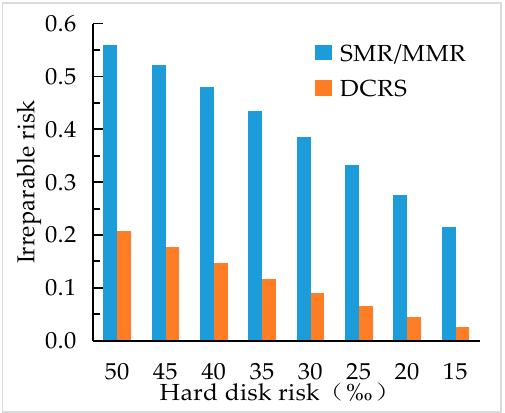
Figure 5. System Unrepair Risk. Figure 7. System Unrepair